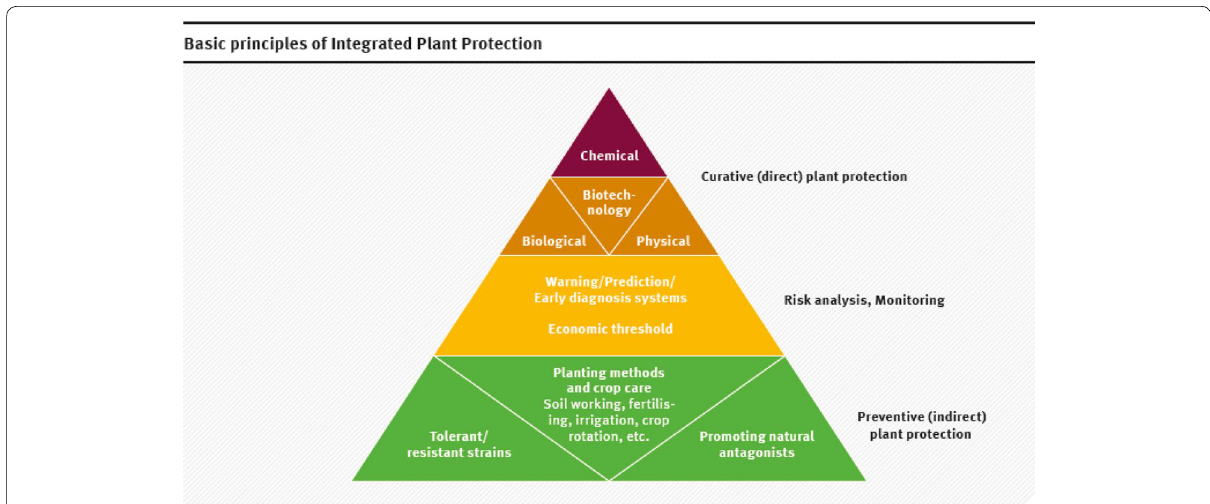
Fig. 4 Basic principles of Integrated Plant Protection (from a talk on “Nutzen und Risiken von Pestiziden” by Dr. Eva Reinhard, BLW, Bern, 10.11.2014 at Oekotoxzentrum Dübendorf,